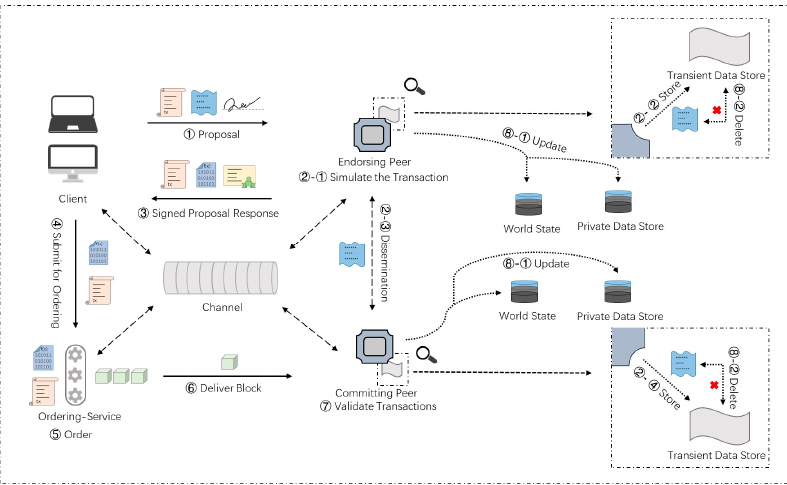
Figure 5. Transaction workflow in the organization-level scheme. Table 3. More components in the transaction process using private